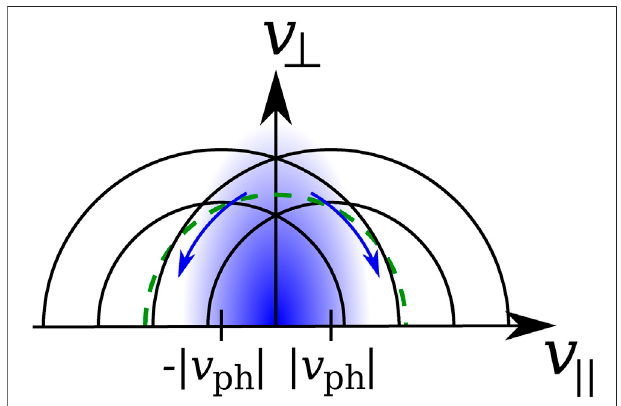
FIGURE 4 | Schematic illustration of the quasi-linear diffusion in the electron whistler anisotropy instability. The blue shaded area represents the anisotropic electron population with T ⊥ e > T (cid:2) e . The black semi-circles represent Eq. 17 for fast-magnetosonic/whistler waves with parallel phase speed | v ph | (propagating in the direction parallel to B 0 ) and − | v ph | (propagating in the direction anti-parallel to B 0 ). The diffusive fl ux of cyclotron- resonantparticles isshown bythe blue arrows. The green-dashed semi-circle indicates v 2 ⊥ + v 2 (cid:2) (cid:3)